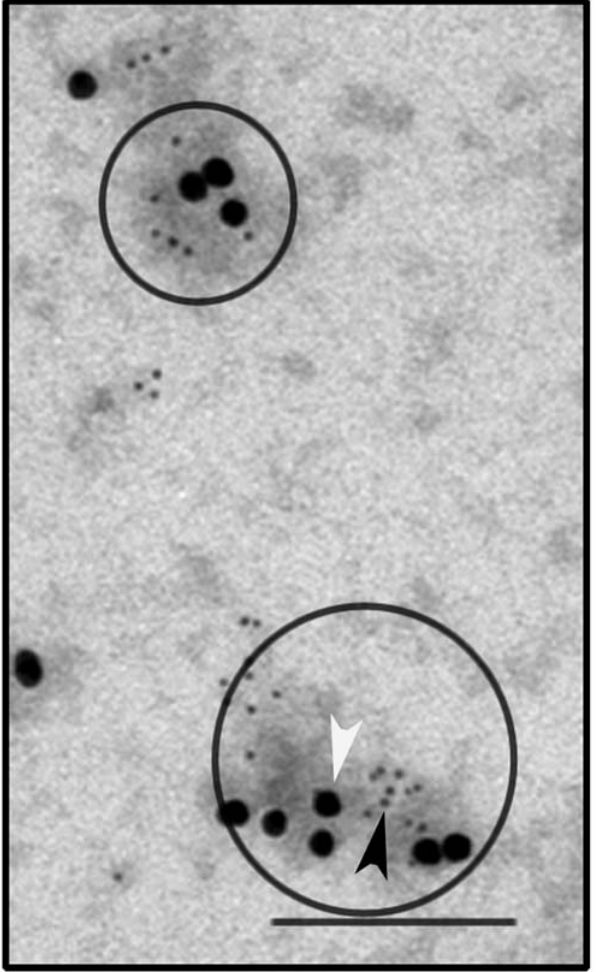
Figure 1. a 1A -AR and cav-1 colocalization in DU145 cell surface. Plasmamembraneswere‘‘ripped-off’’asdescribedinthe‘‘Methods’’section and incubated with anti-cav-1 and anti- a 1A -AR antibodies. Secondary antibodies coupled with 6 nm and 18 nm gold particles were used against anti- a 1A -AR (black arrowhead) and anti-cav-1 (white arrowhead) respective- ly. Grids were then processed for electron microscopy observation. Colocalization of both proteins is indicated by circles. Bar, 200 nm.